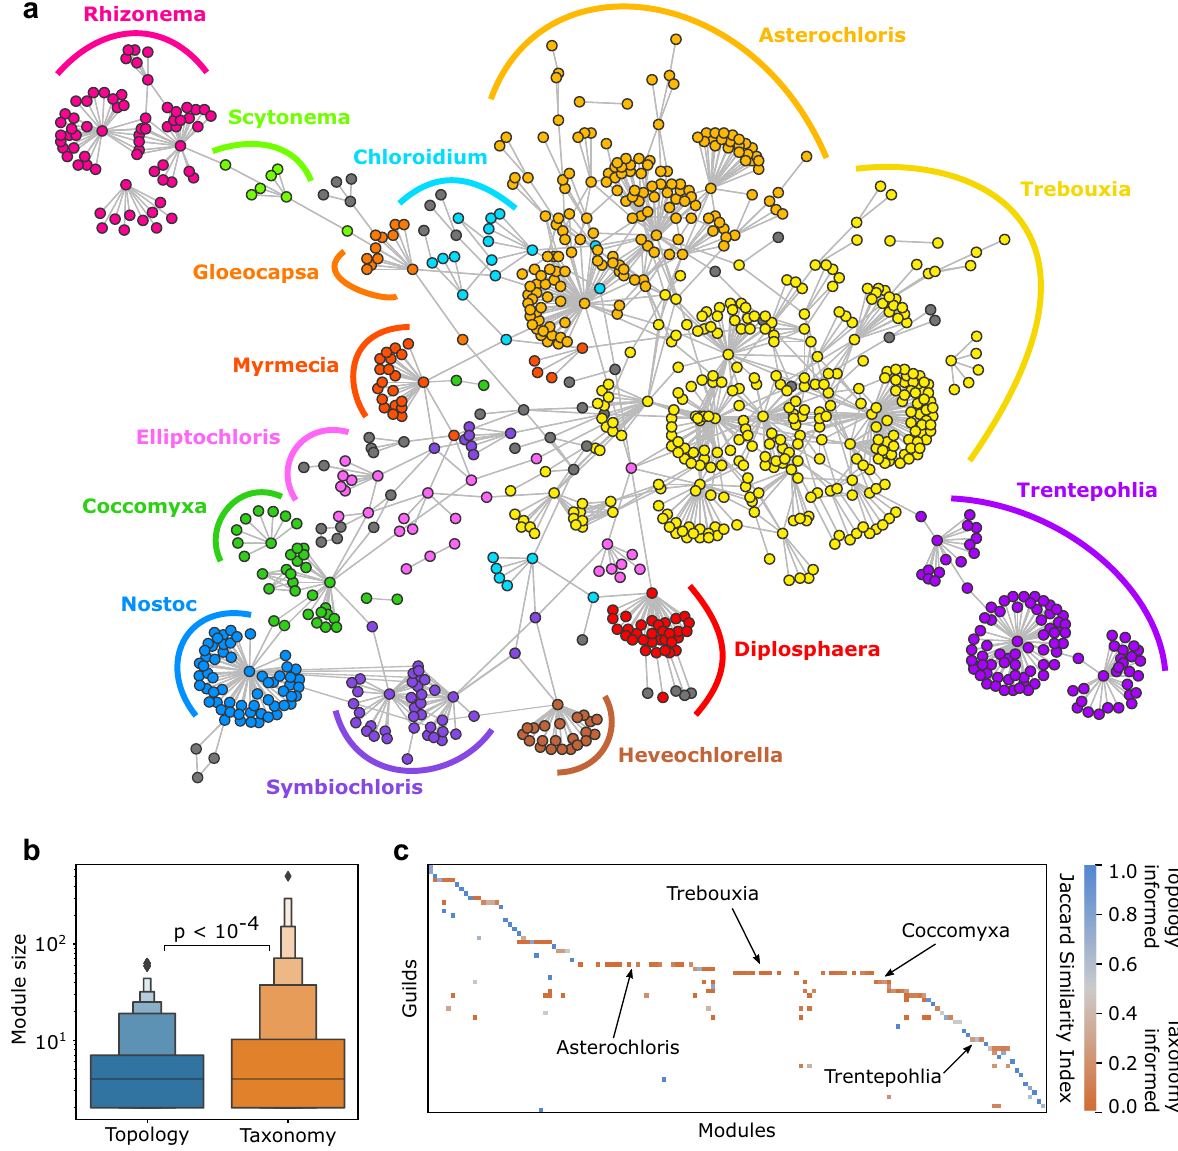
Figure 5. Comparing topological and taxonomic signatures of photobiont-mediated guilds. ( a ) Guilds predicted by photobiont taxonomic information in the largest subweb of the photobiont-mycobiont association network. Large guilds are represented by color, while minor guilds are represented by grey (clusters with fewer than five nodes). Network layout was automatically generated with the FMMM algorithm (see “Materials and methods”). ( b ) Module size distributions for two methods of guild allocation: a topological definition based on network modularity (blue) and a taxonomic definition of guild membership based on photobiont genera (orange). Taxonomic guilds are significantly larger than the topological modules (p-value obtained from t-test statistic). ( c ) Topological modules are incorporated into guilds. For each module-guild pair, we show the Jaccard’s similarity index, which is the intersection over union of the two sets of species. Some guilds (in blue) correspond to topologically defined modules, while others include several modules (in orange, see